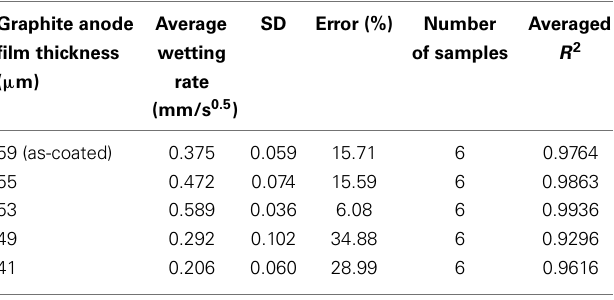
Table 2 | Results summary for porosity and average pore diameter from mercury intrusion porosimetry